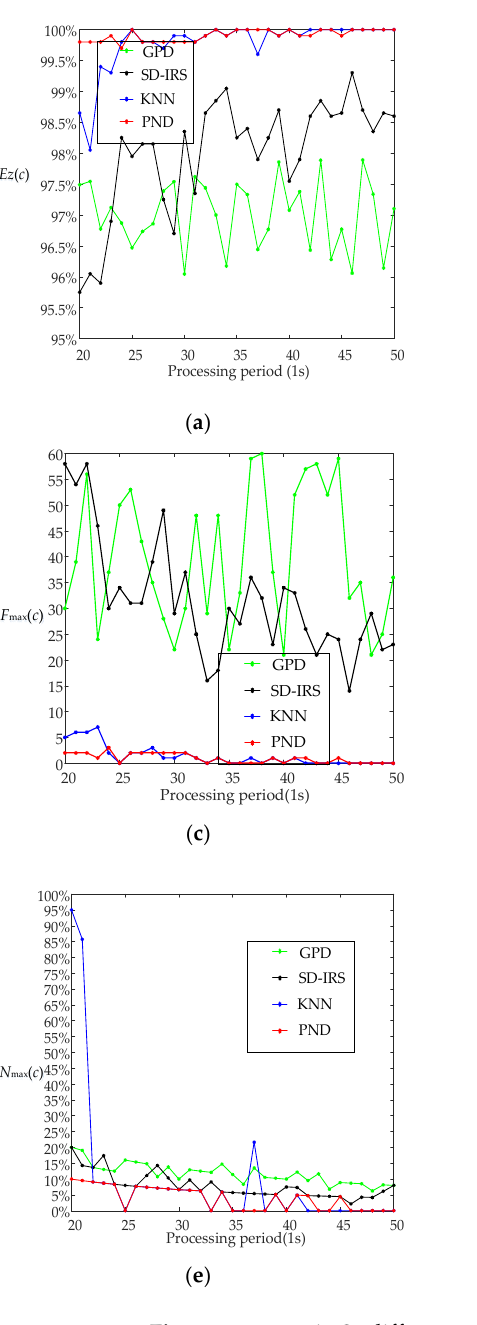
Figure 5. scenario 2: different processing periods and different movement forms. ( a ) Ez ( c ) comparison of different algorithms under the condition of uniform linear motion of targets; ( b ) Ez ( c ) comparison of different algorithms in the case of target turning at constant speed; ( c ) F max ( c ) comparison of different algorithms under the condition of uniform linear motion of targets; ( d ) F max ( c ) comparison of different algorithms in the case of target turning at constant speed; ( e ) N max ( c ) comparison of different algorithms under the condition of uniform linear motion of targets; ( f ) N max ( c ) comparison of different algorithms in the case of target turning at constant speed.